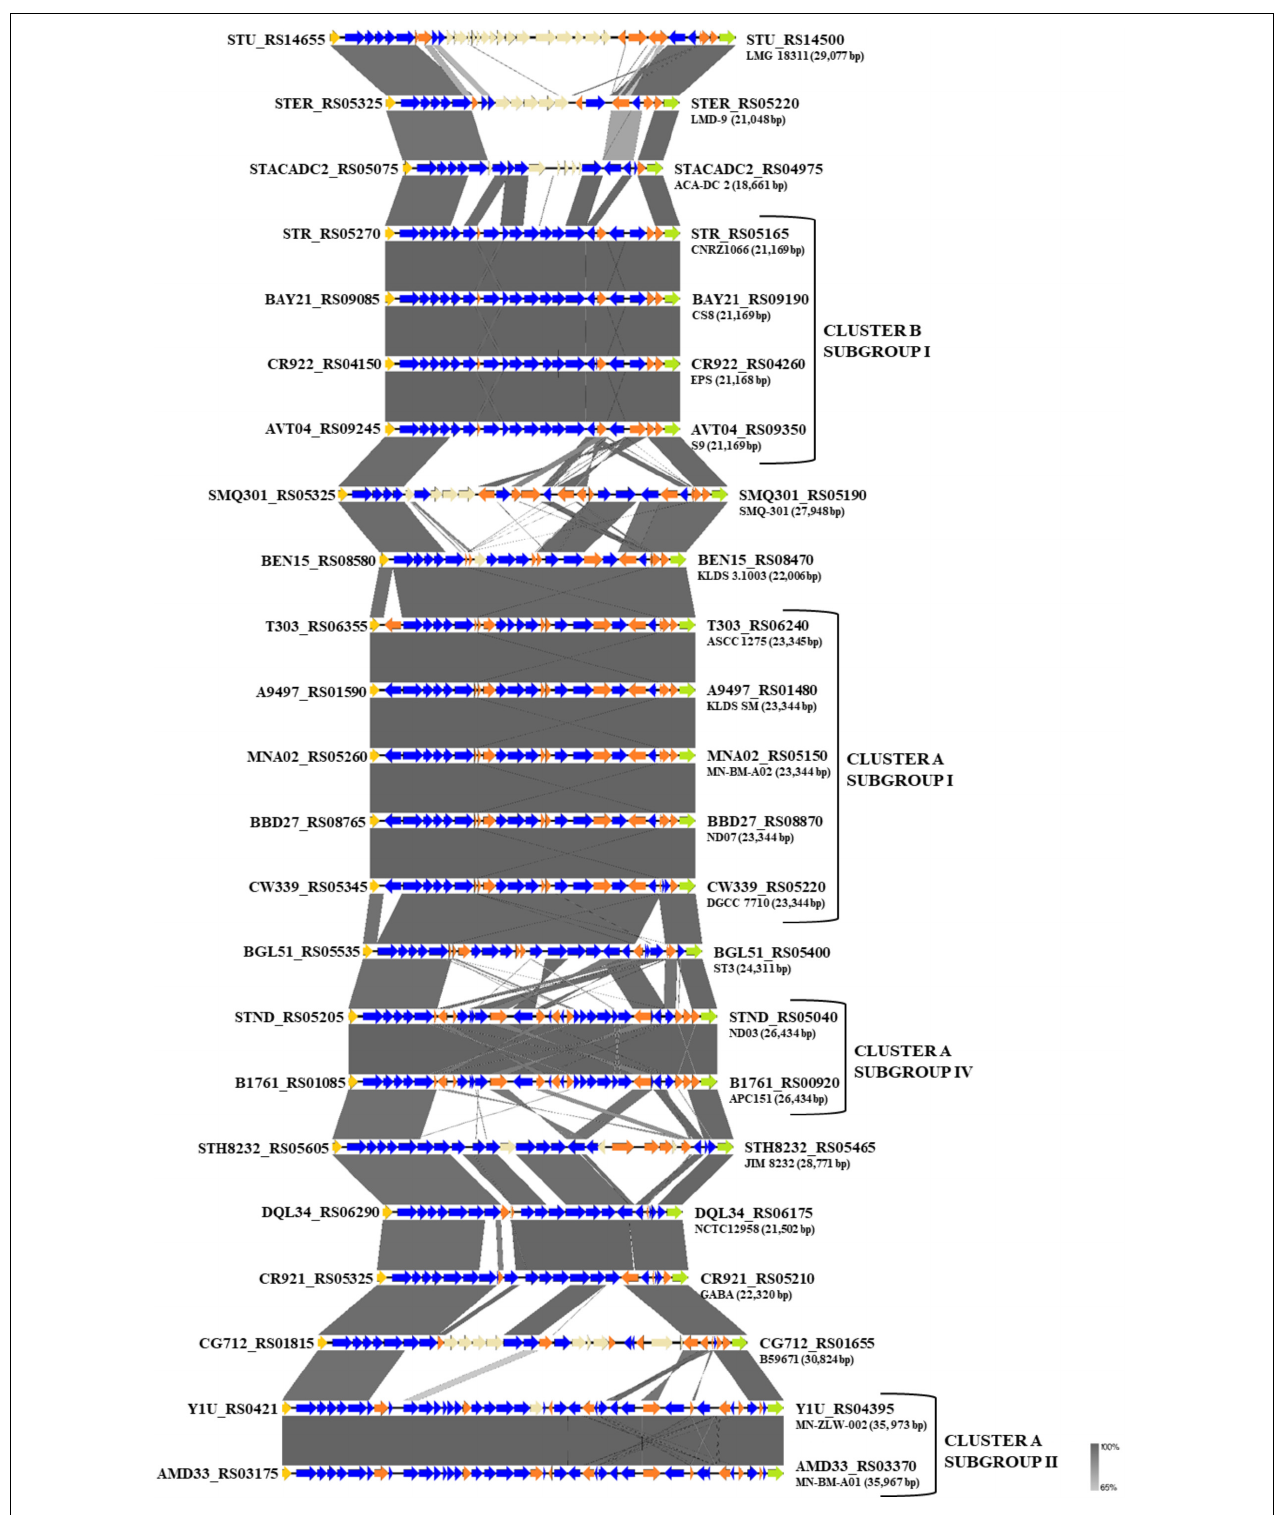
FIGURE 6 | Multiple sequence alignment of the exopolysaccharide (EPS) gene clusters of the 23 S. thermophilus strains after BLASTN analysis. Gray shading represents the % identity among the nucleotide sequences according to the color gradient presented at the lower right corner of the figure. Protein coding genes are highlighted in dark blue, putative pseudogenes in orange, the deoD in yellow, the transporter gene in green and the unique genes for each S. thermophilus strain in beize. Clusters and subgroups of strains are highlighted.